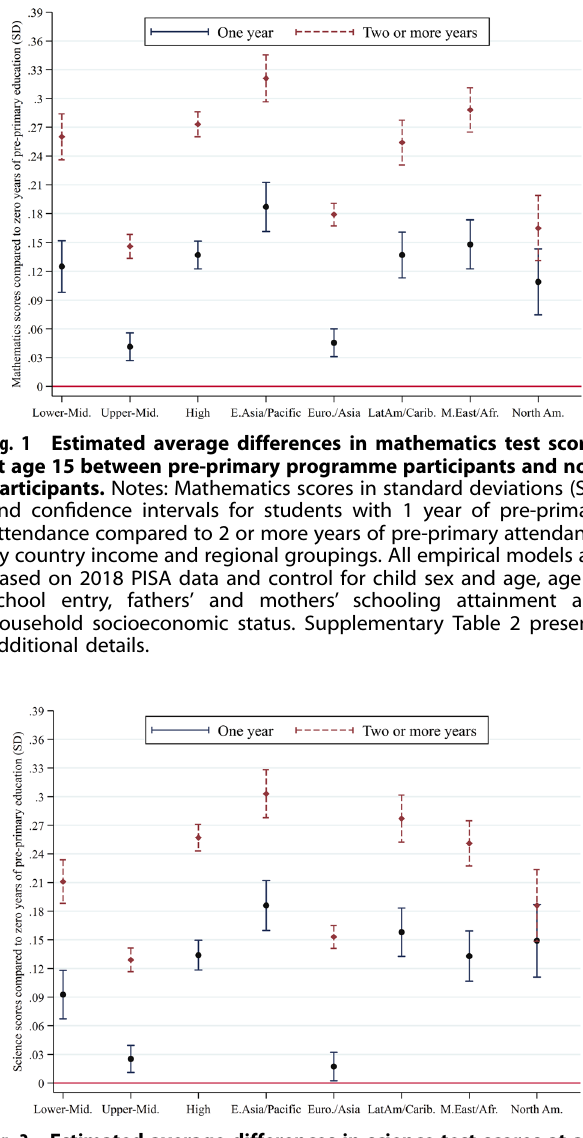
Fig. 2 Estimated average differences in science test scores at age 15 between pre-primary programme participants and non- participants. Notes: Science scores in standard deviations (SD) and con fi dence intervals for students with 1 year of pre-primary attendance compared to 2 or more years of pre-primary attendance by country income and regional groupings. All empirical models are based on 2018 PISA data and control for child sex and age, age of school entry, fathers ’ and mothers ’ schooling attainment and household socioeconomic status. Supplementary Table 3 presents additional